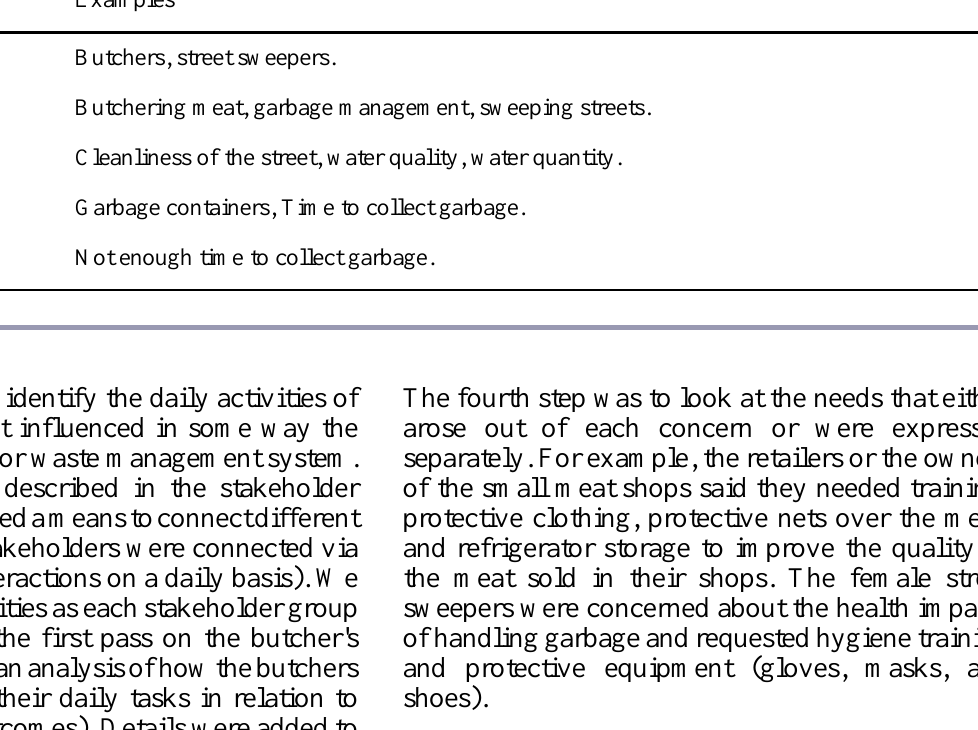
Table 1 . Eco-social system elements contributing to ecosystem health.